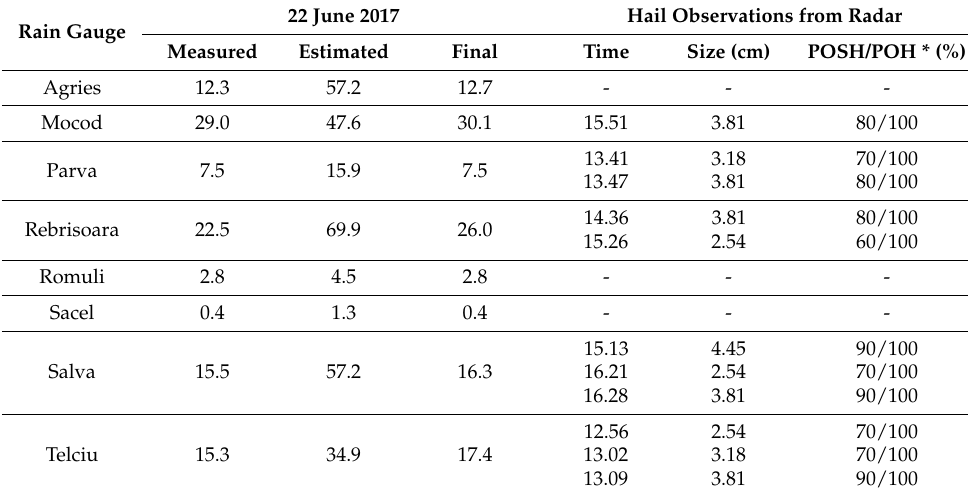
Table 4. Radar precipitation estimates influenced by ice cores.